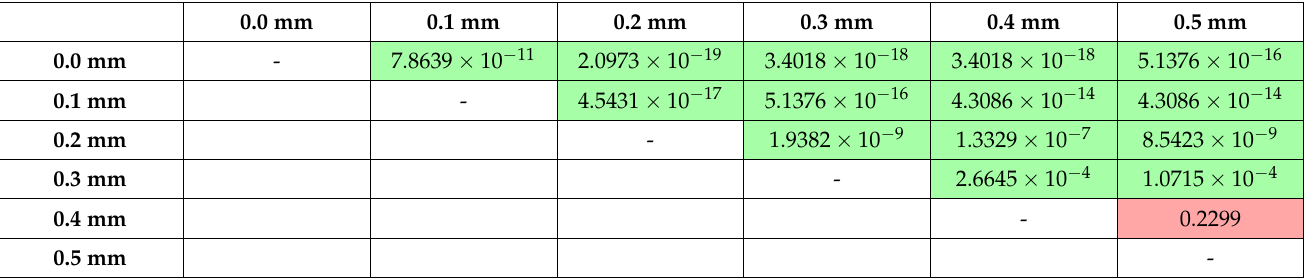
Table 2. p -values obtained by a sign test for all wooden floor images. Green cells are those that have a statistically significant difference whereas red cells are those that do not have a statistically significant difference. The threshold used in the Bonferroni correction is 0.05/15 =